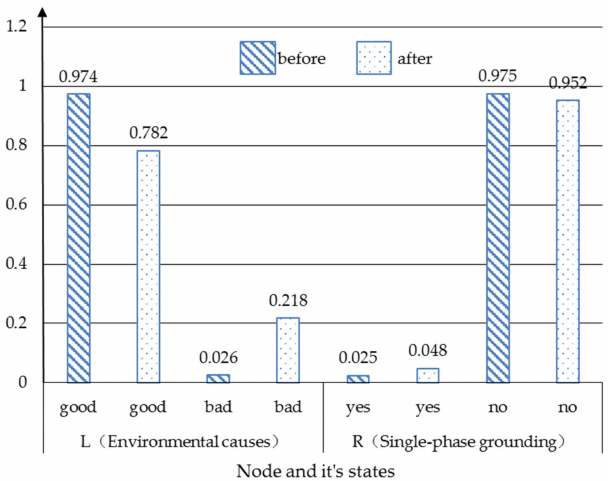
Figure 7. The probability changes before and after the “Environmental cause” and “Single-phase grounding”